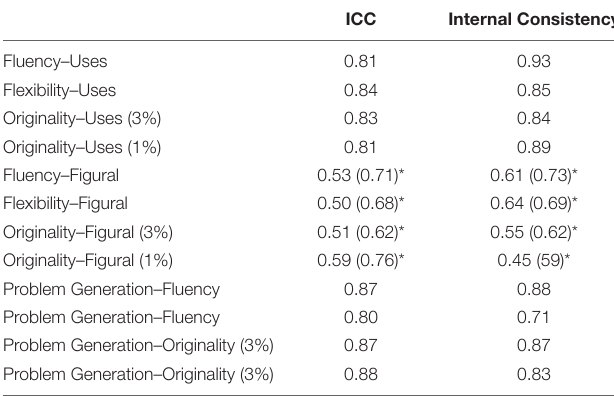
TABLE 3 | Interclass and internal consistency reliability coefficients of study